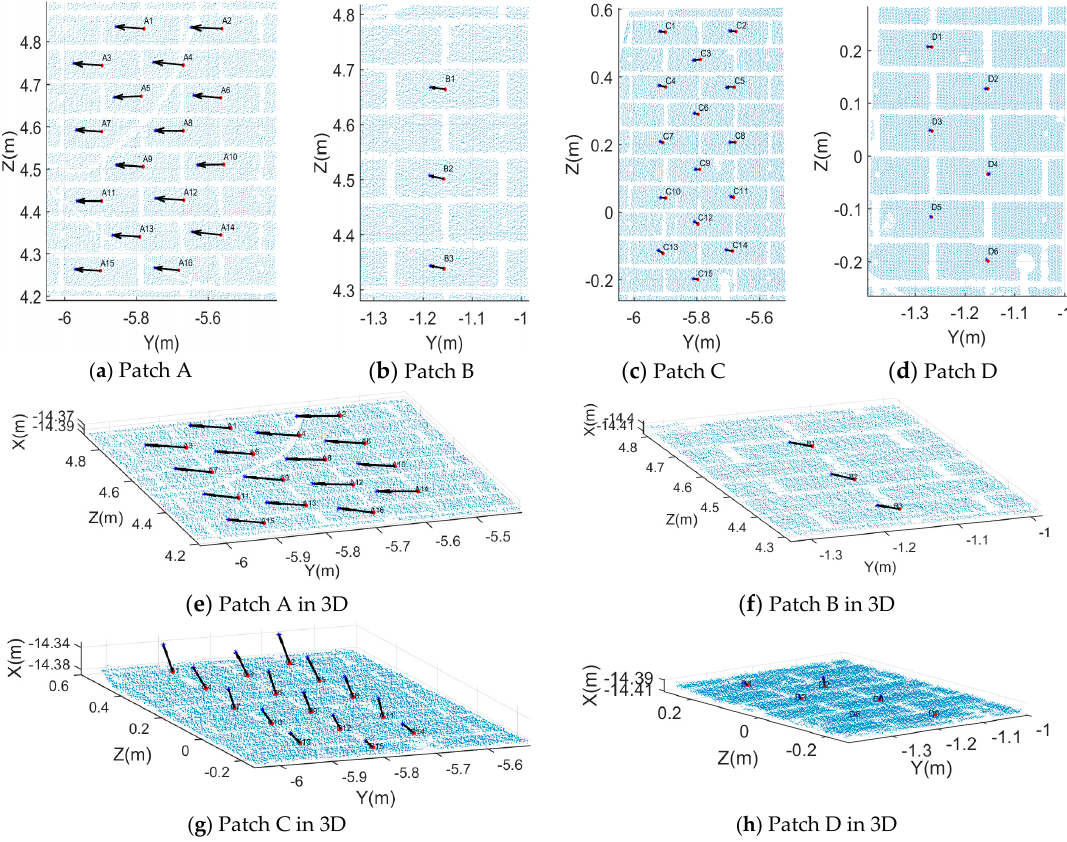
Figure 18. Direct virtual point comparison results.